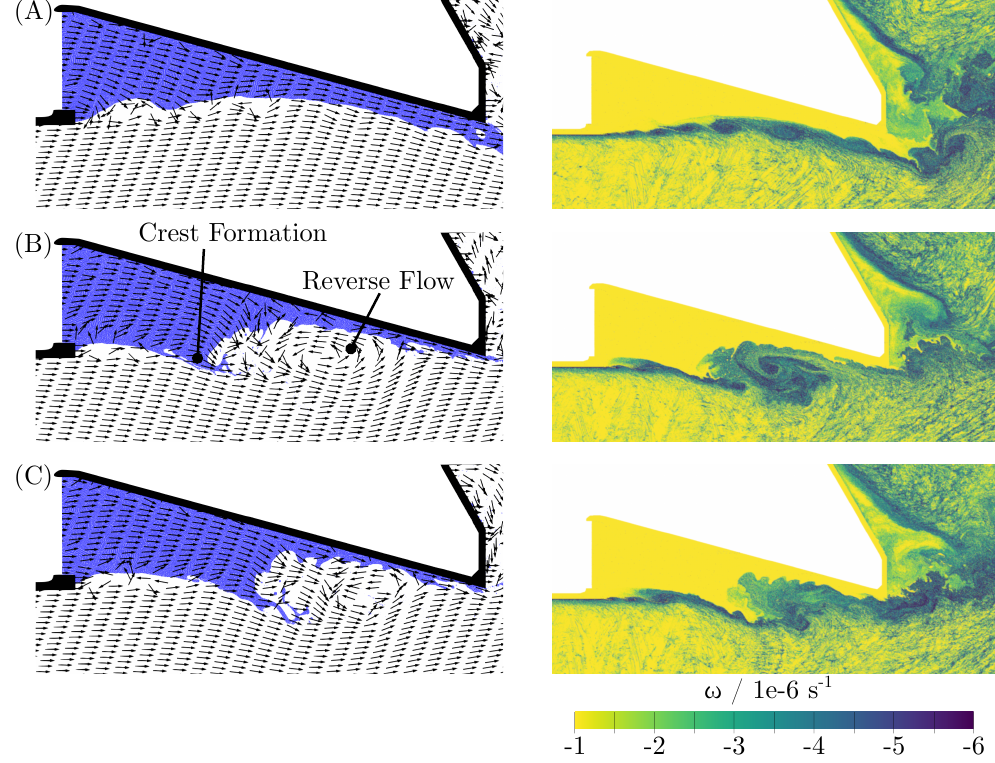
Figure 5. Instantaneous velocity vector and vorticity fields. ( A ): Balanced Condition t 0 ; ( B ): Vortex Formation t 1 ; ( C ): Flow Reversal t 2